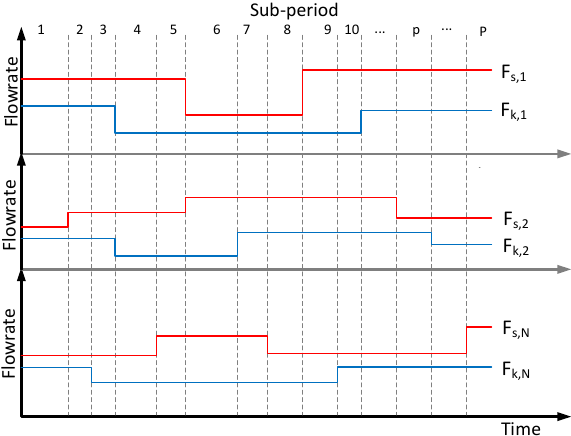
Figure 2. The partitioning of subperiods and flowrates fluctuation of hydrogen sources and hydrogen sinks in different plants. F s : the flowrate of hydrogen source; F k : the flowrate of hydrogen sink.